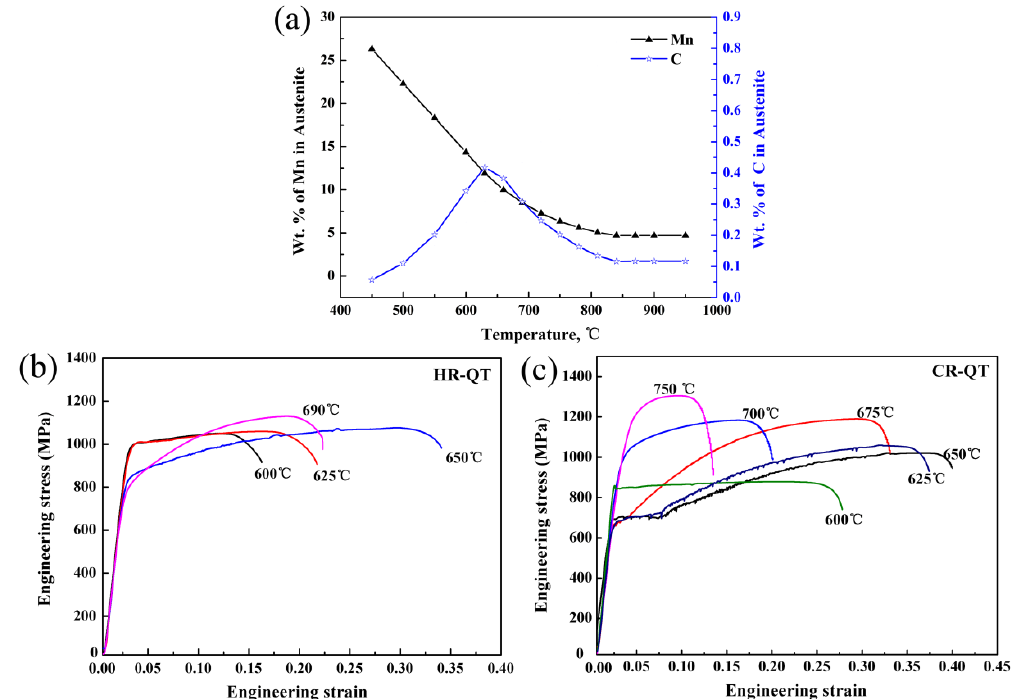
Figure 5. ( a ) Variation of Mn and C equilibrium content of austenite at different annealing temperatures (using Thermo-Calc combined with the TCFE7 database); engineering stress–strain curves of ( b ) HR-QT and ( c ) CR-QT